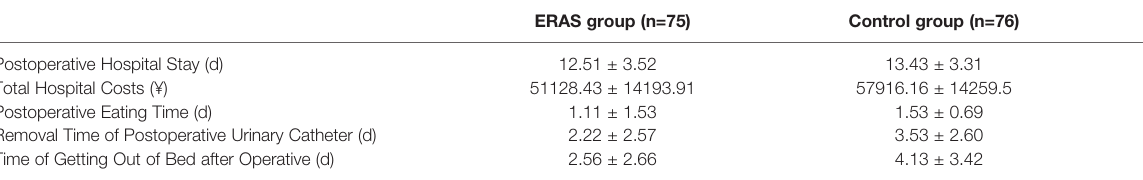
TABLE 1 | Clinical outcomes.